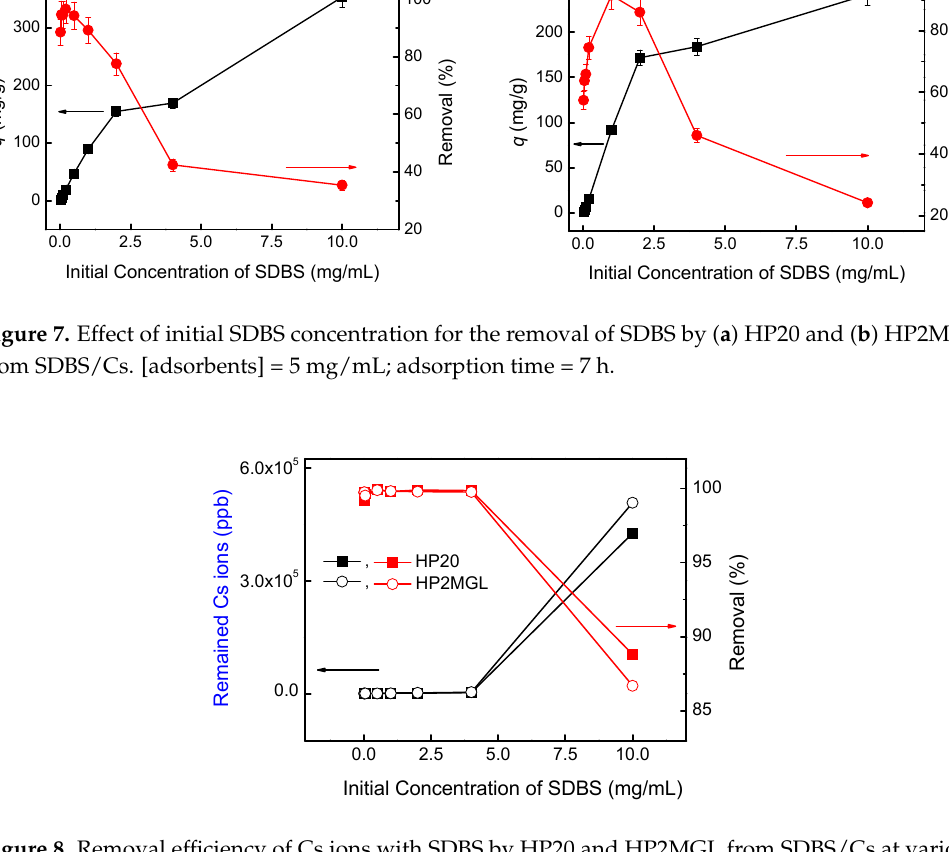
Figure 8. Removal efficiency of Cs ions with SDBS by HP20 and HP2MGL from SDBS/Cs at various initial concentrations of SDBS. [adsorbents] = 5 mg/mL; adsorption time 7 h.